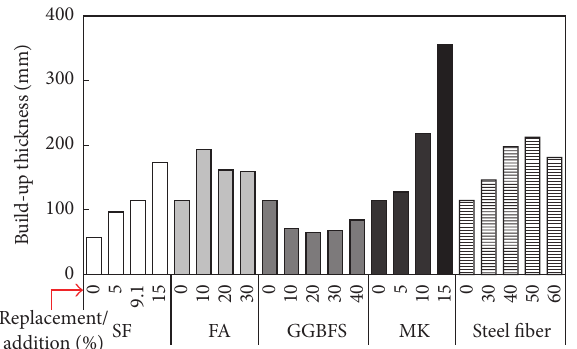
Figure 12: Shootability (build-up thickness) predictions for various WMS mixtures.